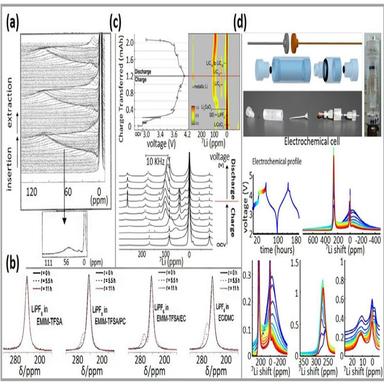
(a) In-situ 7 Li NMR spectra of plastic Li/hard carbon battery (Reproduced with permission from ref. Copyright 2003 American Institute of Physics); (b) in-situ 7 Li NMR of lithium deposition in Li/Li cells with various electrolytes (Reproduced with permission from ref. Copyright 2013 Elsevier); (c) 7 Li NMR MAS spectra of LiCoO2/graphite cell for the first cycle (Reproduced with permission from ref. Copyright 2019 American Chemical Society); (d) operando 7 Li NMR te